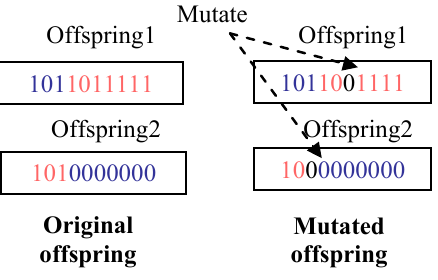
Figure 3. Genetic operators: crossover and mutation.